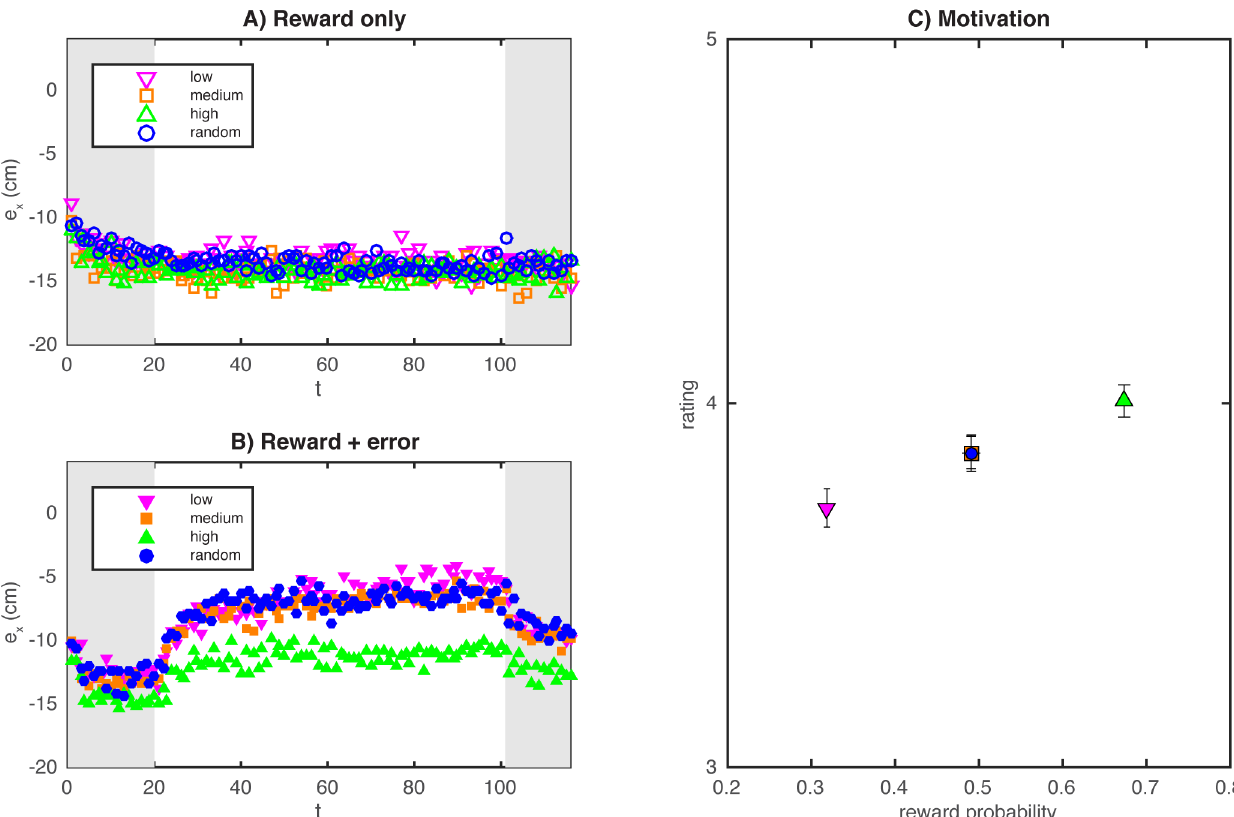
Fig 2. Main results averaged over participants. A) Lateral pointing error in the different reward groups of the reward only condition. B) Lateral pointing error in the different reward groups of the reward + error condition. C) IMI rating for the different reward conditions (low, medium, high, random) as a function of the proportion rewarded trials with standard error of the mean. The results for the random and medium reward condition are overlapping.